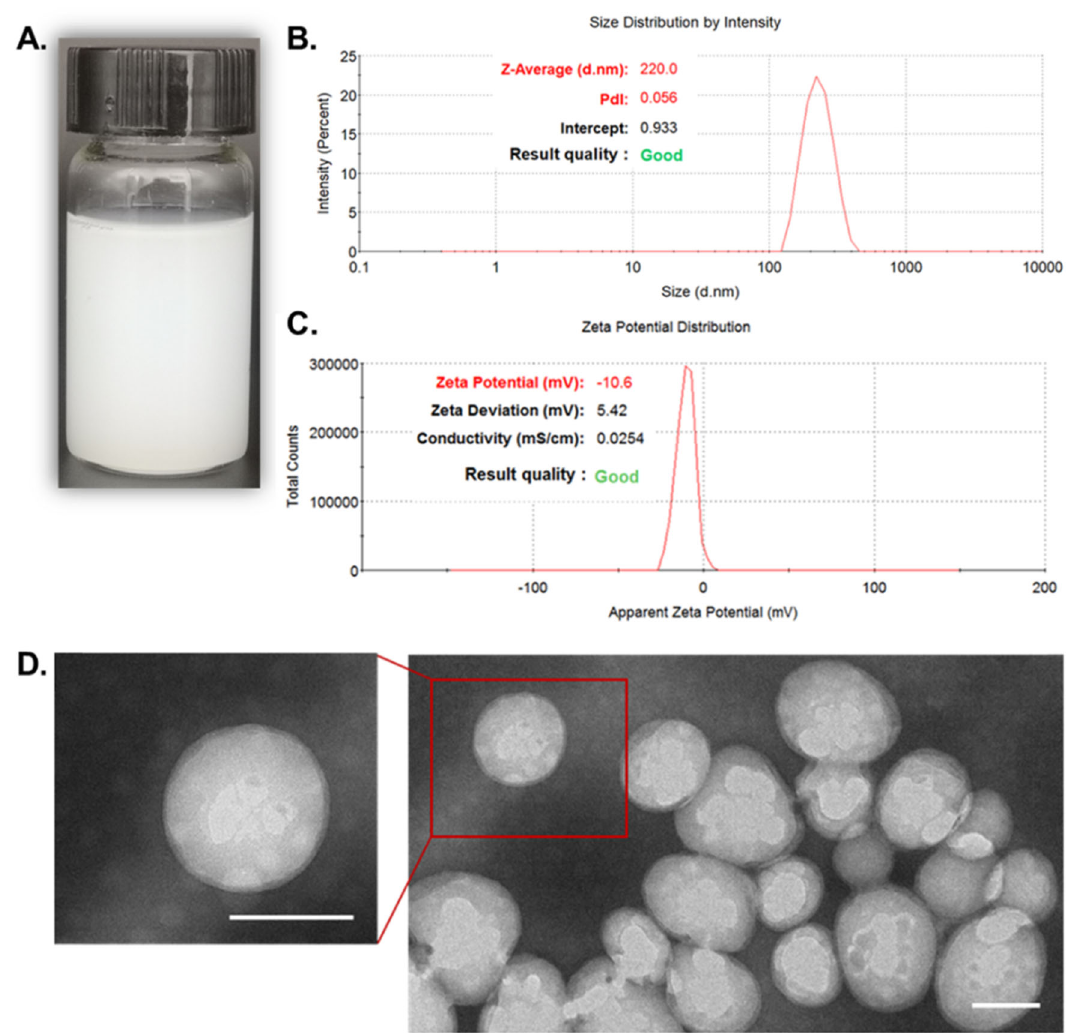
Fig. 1 Characterization of PPUNPs. A The photo image of PPUNPs solution, B PPUNPs particle size distribution in aqueous solution, C Zeta potential of PPUNPs in aqueous solution, D TEM image of PPUNPs, Scale bar: 100